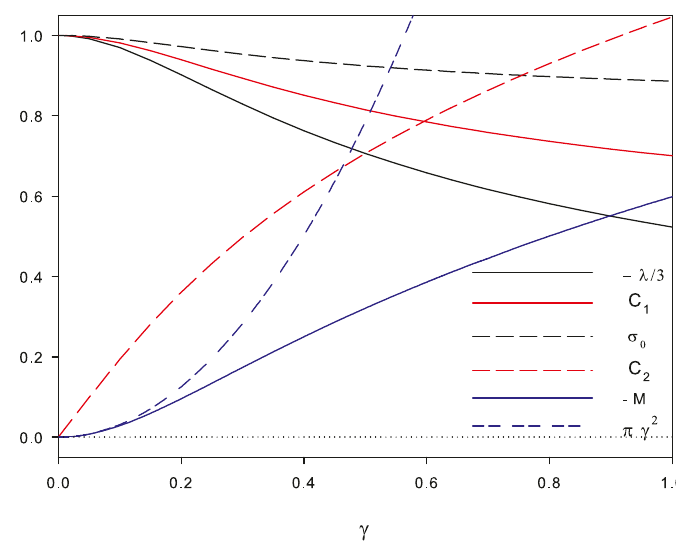
Figure 2 . We show the dependence of the coe(cid:14)cients appearing in the asymptotic expansion (see (2.12)) as well as (cid:27) 0 (see (3.1)) on (cid:13) for soliton solutions with (cid:3) = (cid:0) 3. Note that the negative value of the mass parameter (cid:0) M , which for our choice of (cid:3) = (cid:0) 3 reads (cid:0) M = (cid:25)(cid:13) 2 + O ( (cid:13) 4 ),